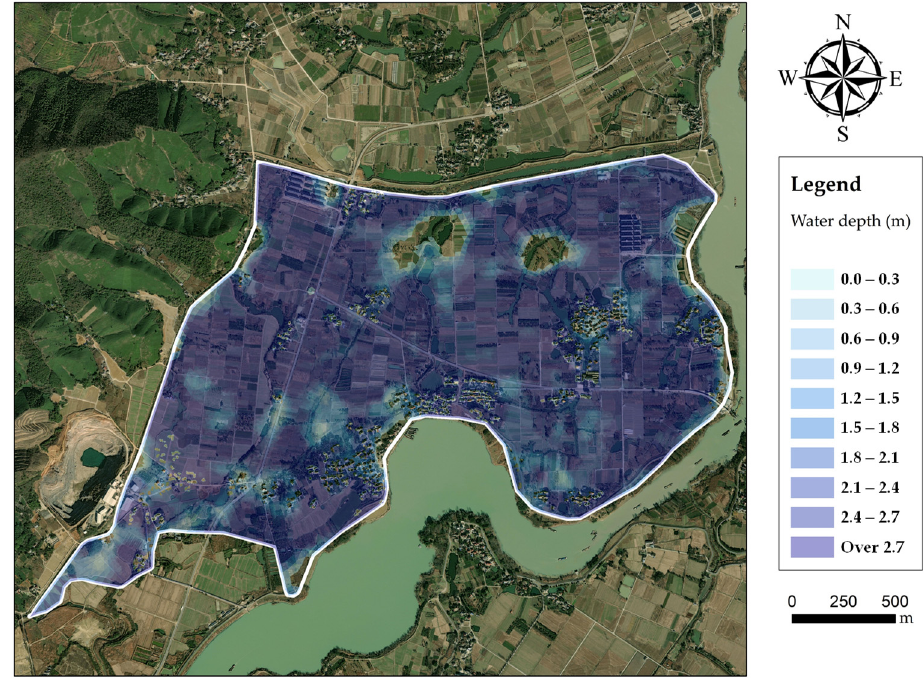
Figure 9. Inundated areas in flood scenario of 50-year return period.